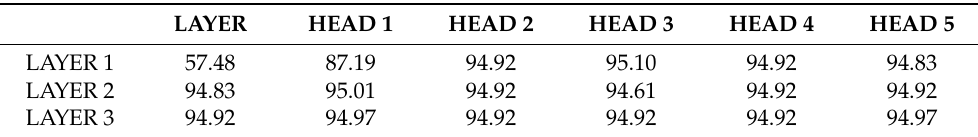
Table 3. Accuracy (%) of pruning a T-GEM layer or head for TCGA-based cancer type classification (original accuracy is 94.92%).